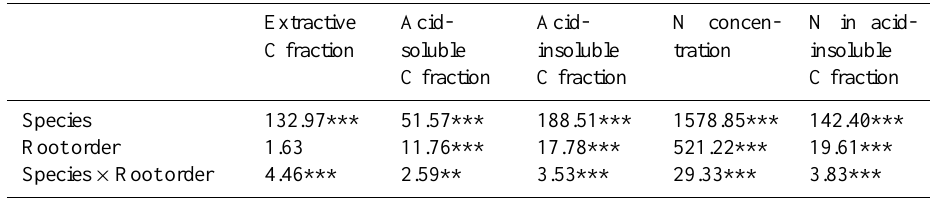
Table 1. F values of two-way ANOVAs testing effects of plants species and root branch order on the extractive C fraction, acid-soluble C fraction, acid-insoluble C fraction, N concentration, and N in acid-insoluble C fraction. *, **, *** are significant level at 0.05, 0.01, 0.001, respectively.